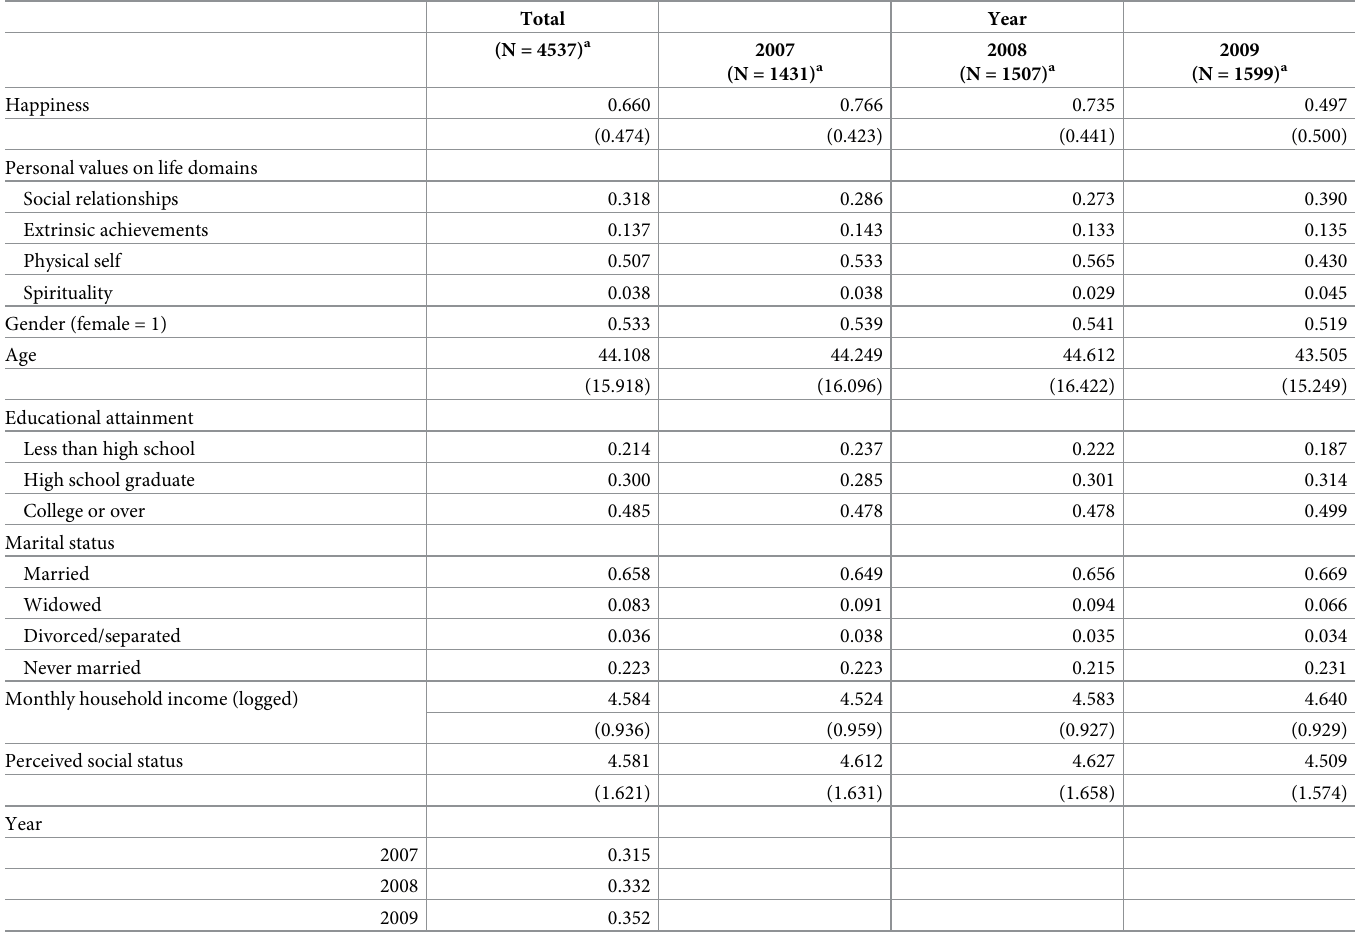
Table 1. Descriptive statistics for all variables in the total sample and across survey